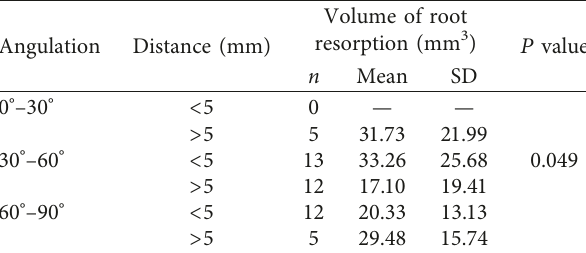
Table 4: Comparison of the MVR in terms of the angle between impacted canine and